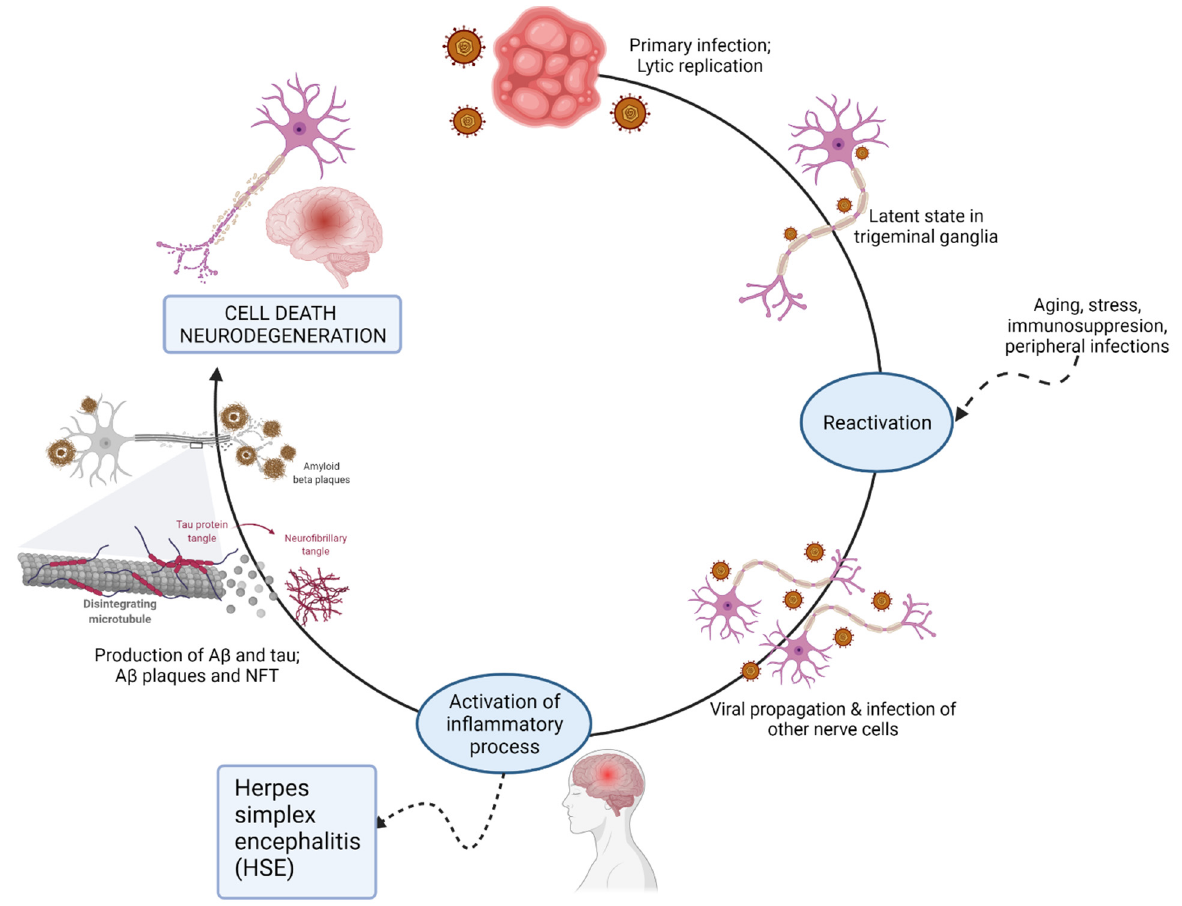
Figure 4. Possible mechanisms for virus-induced